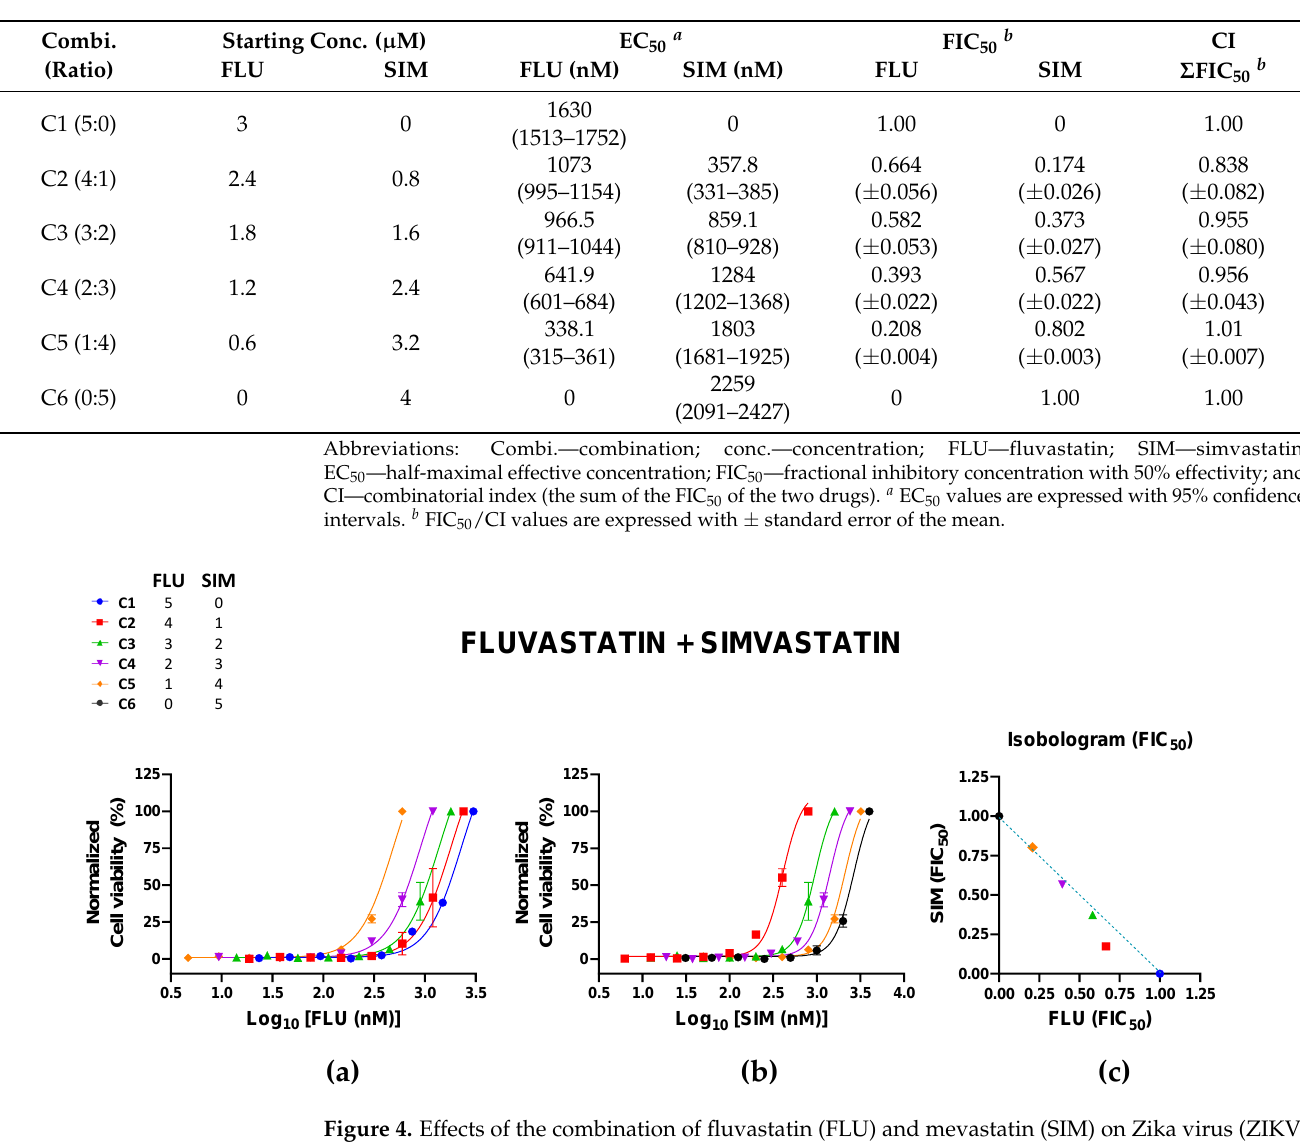
Table 4. Half-maximal inhibitory concentrations for the fluvastatin and simvastatin combinations. Combi.